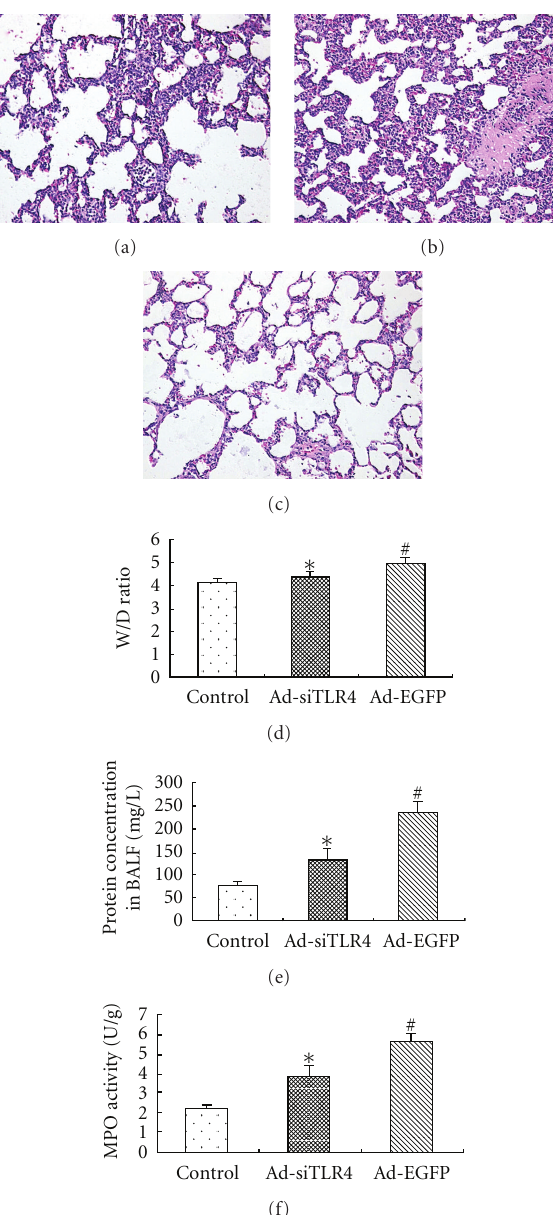
Figure 5: E ff ects of Ad-siTLR4 on LPS-induced ALI. Lungs were collected at 4h after injection of normal saline or LPS for histological examination (a, b, c). Sections were stained with hema- toxylin-eosin. Magnification: × 100 Wet/Dry ratio (d), total protein content in BALF (e) as well as MPO activity (f) were measured to determine the lung edema, microvascular permeability, and neutrophil sequestration, respectively. ∗ P < 0 . 05 versus Ad-EGFP group, # P < 0 . 05 versus control